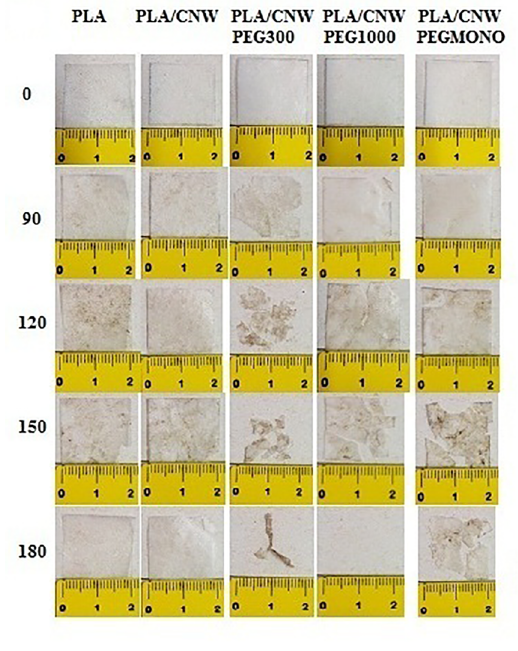
Figure 2. Visual appearance of PLA, PLA/CNW and PLA/CNW/S films before and after 90, 120, 150 e 180 days of exposure to garden